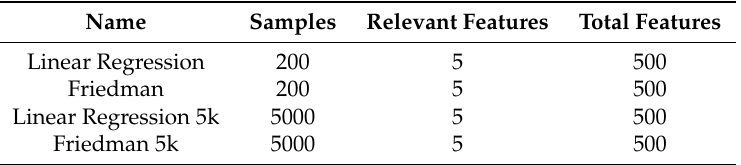
Table 3. Synthetic regression